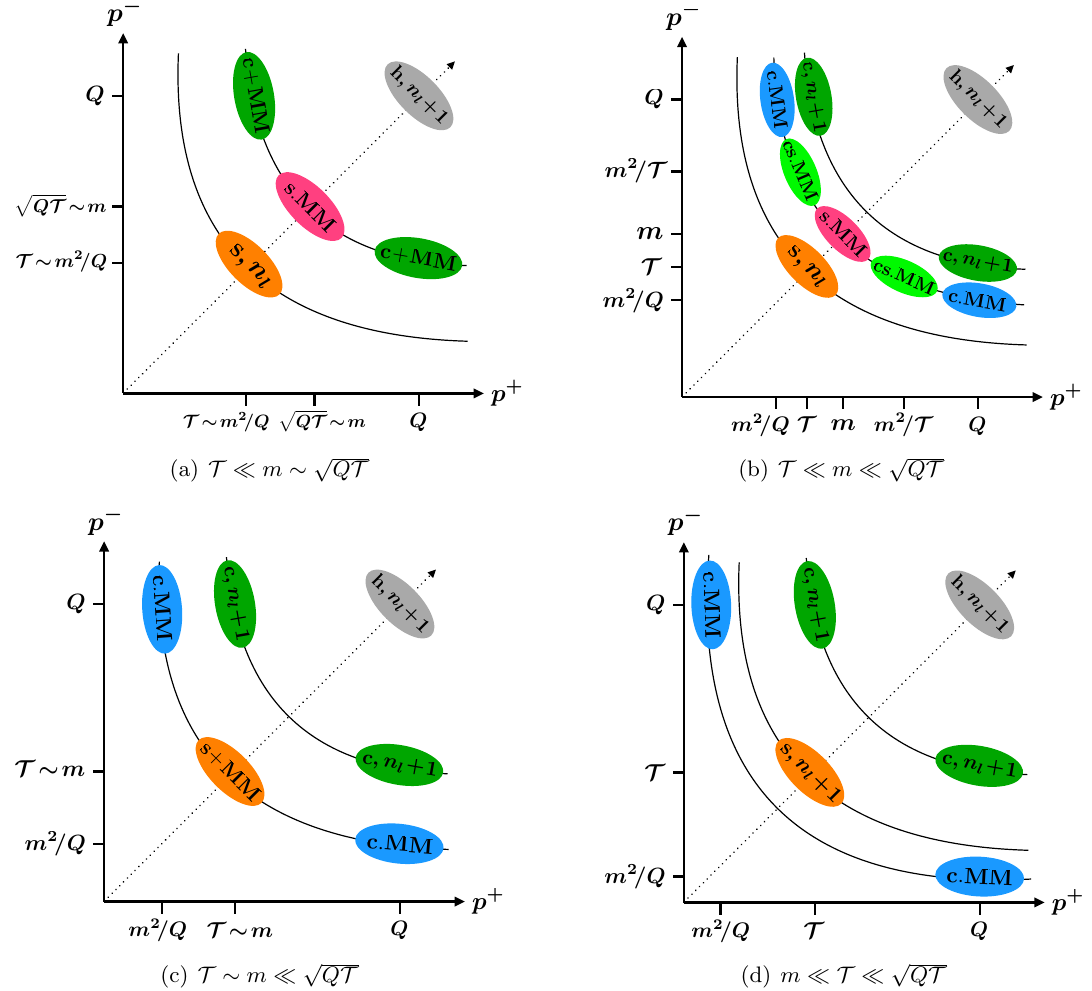
Figure 5 . E(cid:11)ective theory modes for the beam thrust spectrum with massive quarks for m 2 =Q . Q and m (cid:3) QCD T (cid:28) (cid:29)